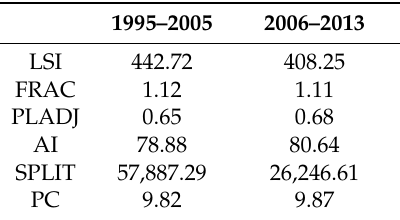
Table 4. Landscape metrics for forest remnants and secondary forest